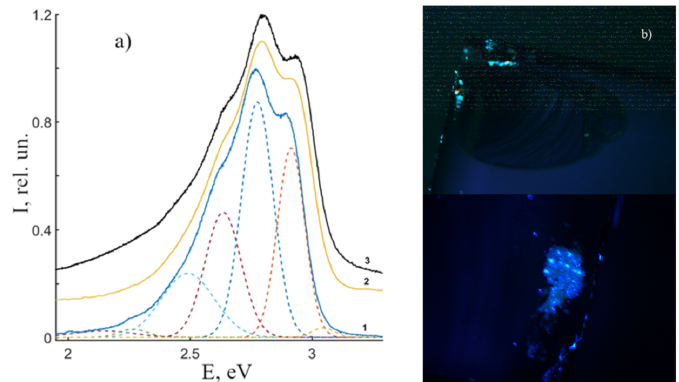
Figure 3. Surface PL spectra of nominally pure LN crystals ( a ): (1)—CLN, (2)—SLN, (3)—SLN (6.0 wt% K 2 O). Microimages of PL on the surface of the CLN crystal ( b